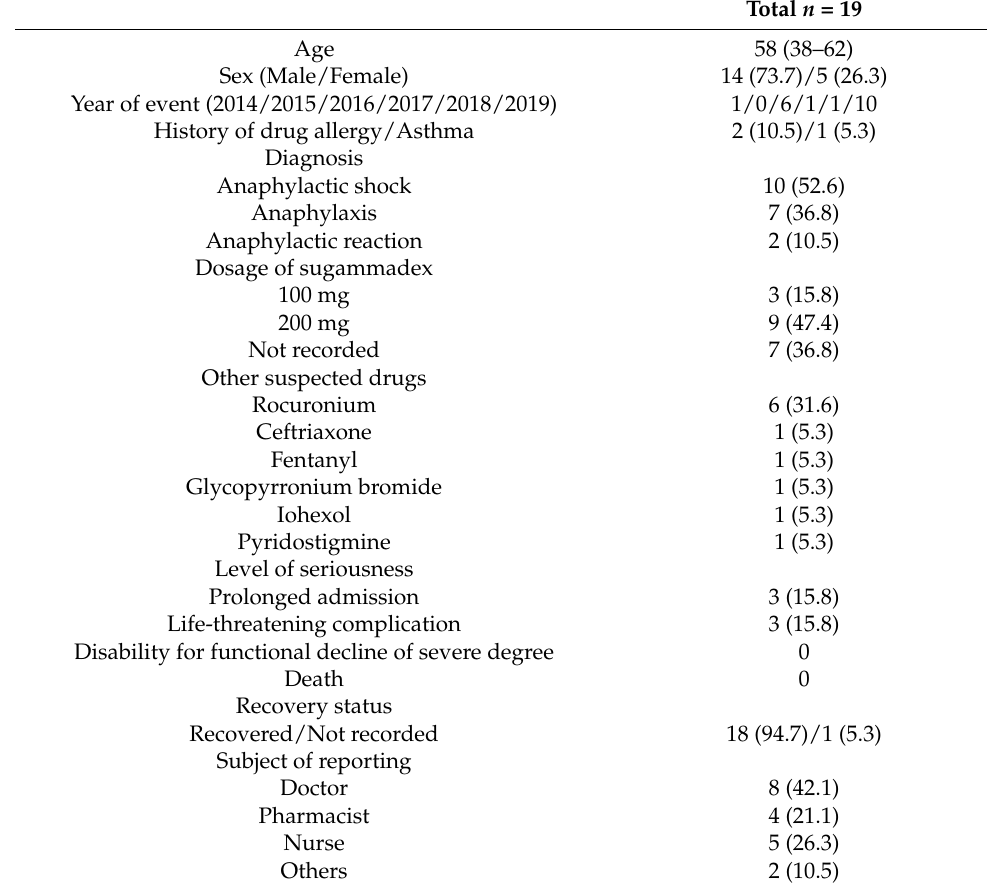
Table 1. Summary of baseline characteristics and anaphylaxis-related information in patients with anaphylaxis to sugammadex in the Korea Institute of Drug Safety & Risk Management-Korea Adverse Event Reporting System